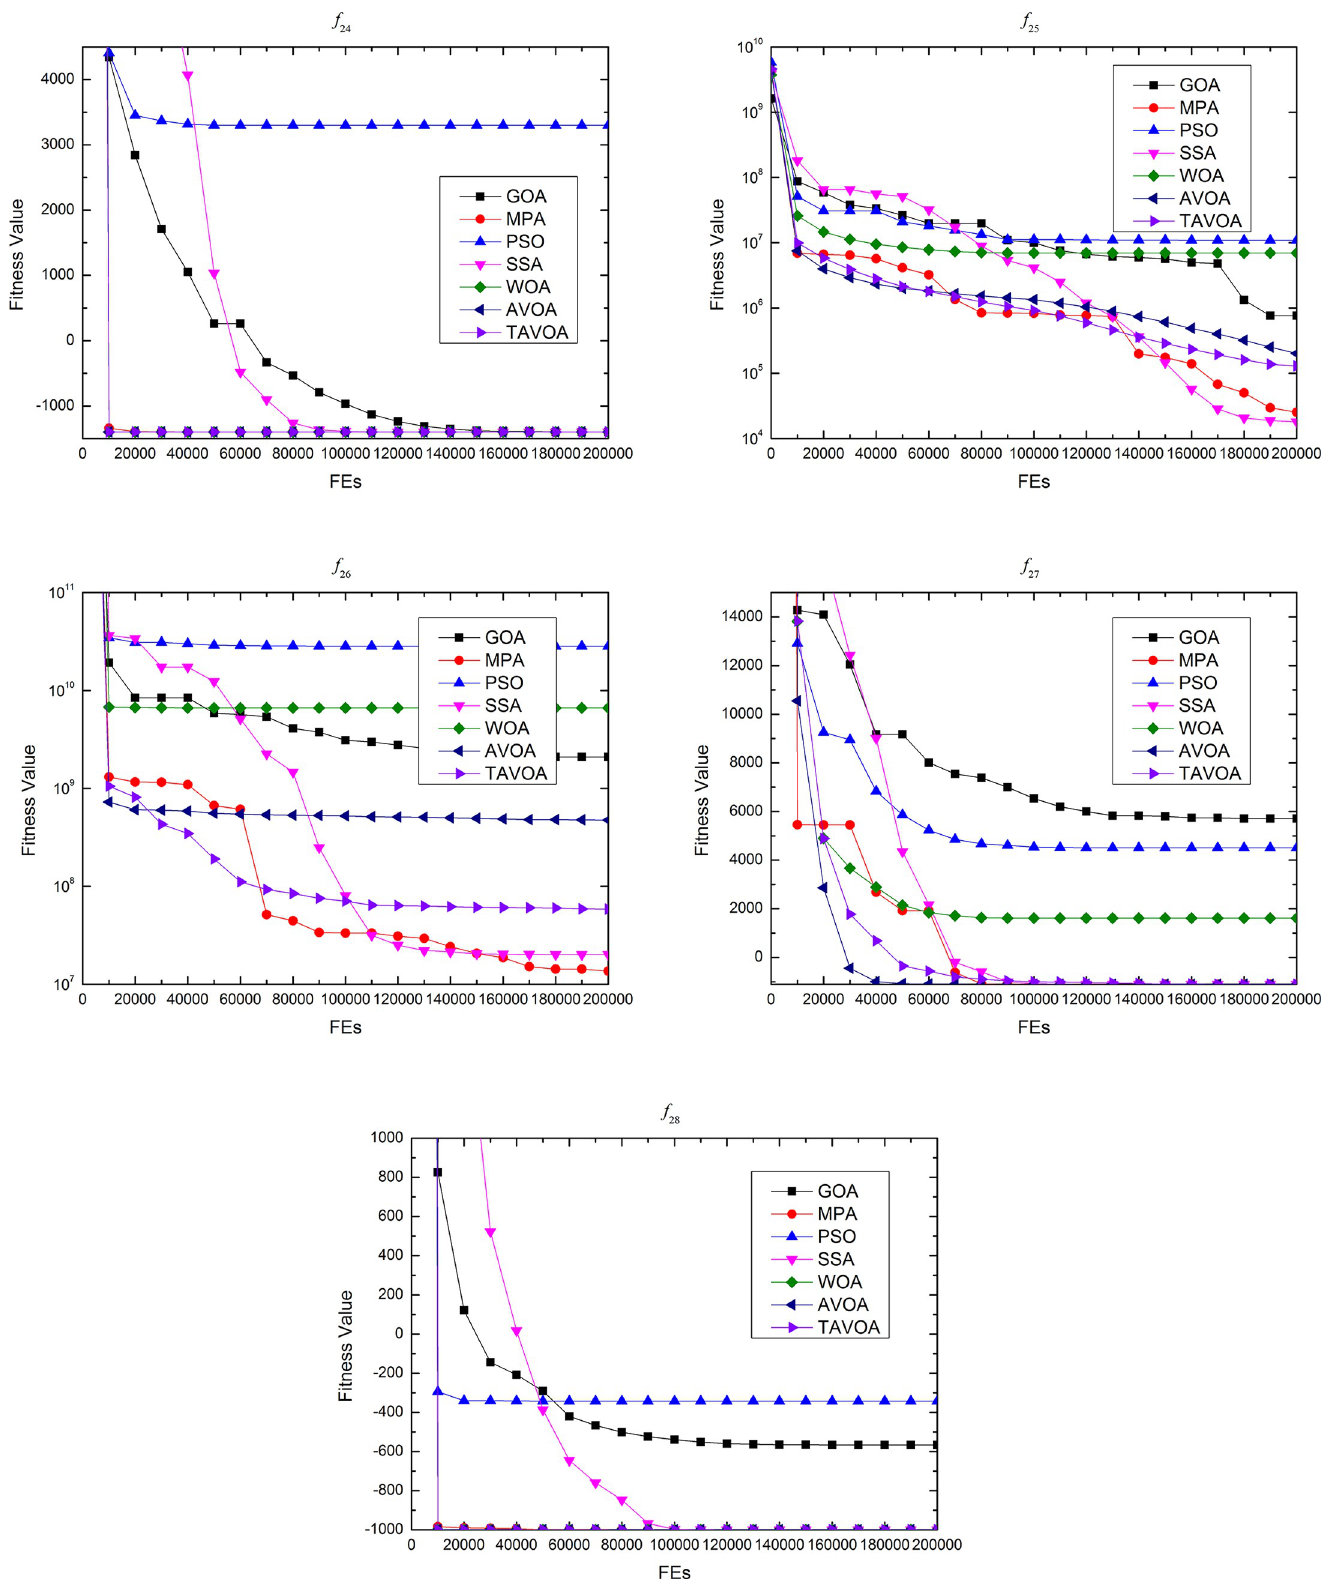
Fig 10. Convergence process on CEC 2013 unimodal benchmark functions. https://doi.org/10.1371/journal.pone.0260725.g010 PLOS ONE | https://doi.org/10.1371/journal.pone.0260725 November30,